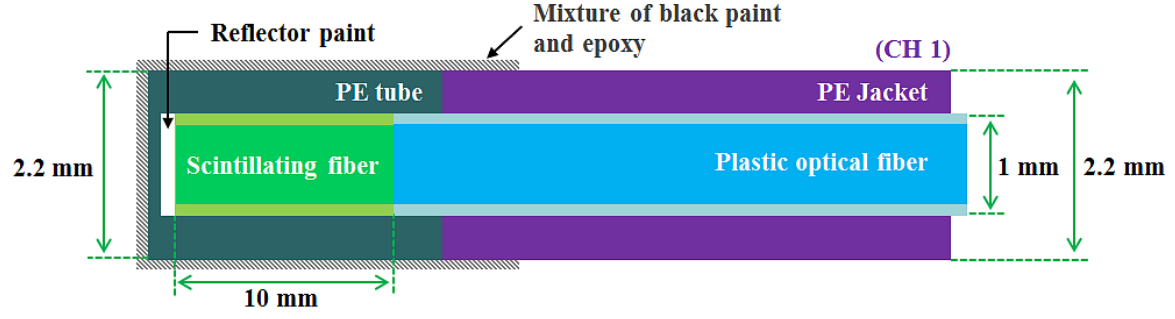
Figure 1. Internal structure of the dosimeter probe.